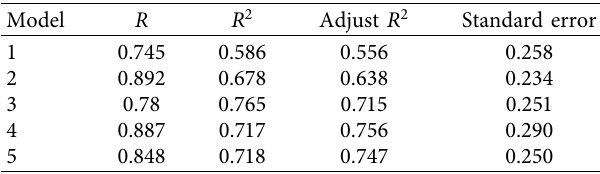
Table 3: Summary of regression models.